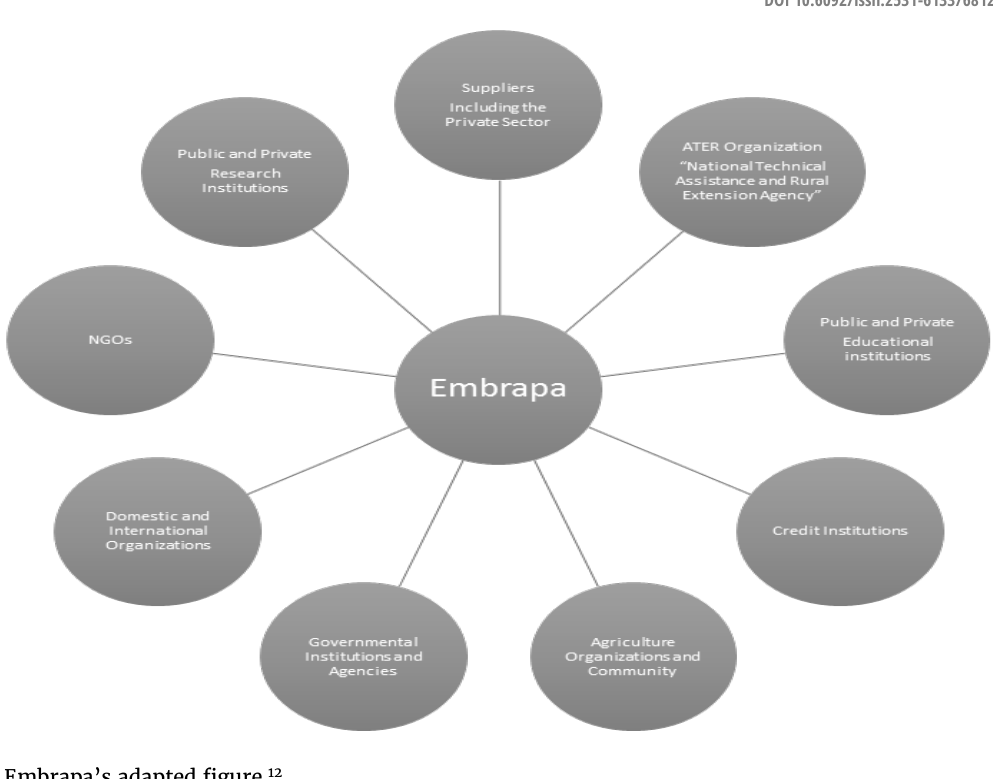
Embrapa’s adapted figure.